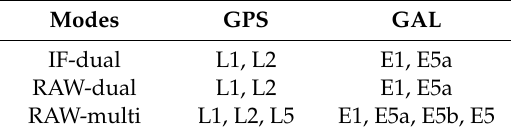
Table 3. Frequencies used for GPS and Galileo IF and RAW PPP